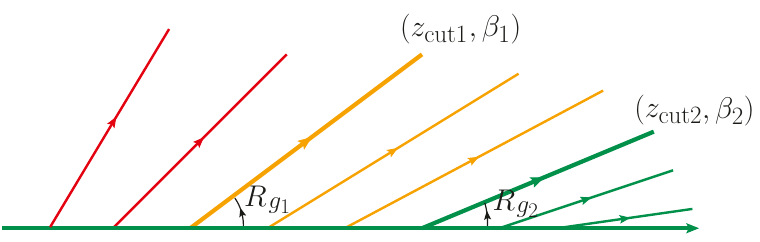
Figure 1 . Illustration of the particles kept in the collinear drop sample, displaying for simplicity a set of angular-ordered emissions from a single branch. The soft-drop parameters SD 1 = ( z cut1 ; (cid:12) 1 ) determine what soft wide-angle red particles are dropped, while the soft-drop parameters SD 2 enforce collinear drop by determining which green collinear particles are dropped. The collinear- drop observable is then de(cid:12)ned on the remaining orange particles, roughly contained between the two groomed jet radii R g and R g 1 2